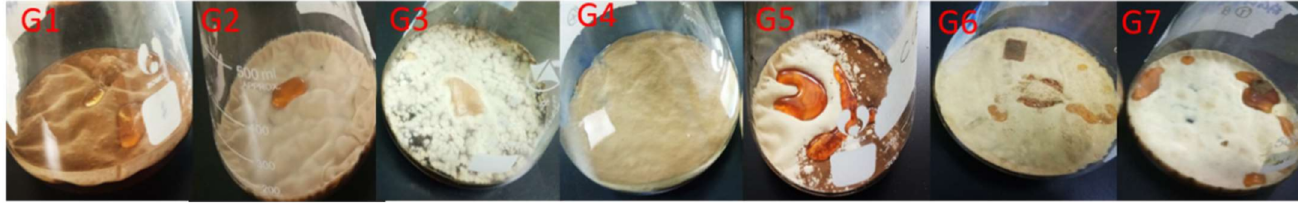
Figure 1. The morphology of axenic cultures and co-cultures in different experiments (28 days in total). ( G1 – G7 ), respectively, represent: axU ( G1 ), axT ( G2 ), iacU-livT ( G3 ), livU-livT ( G4 ), livU/livT ( G5 ), iacT-livU ( G6 ), livT-livU ( G7